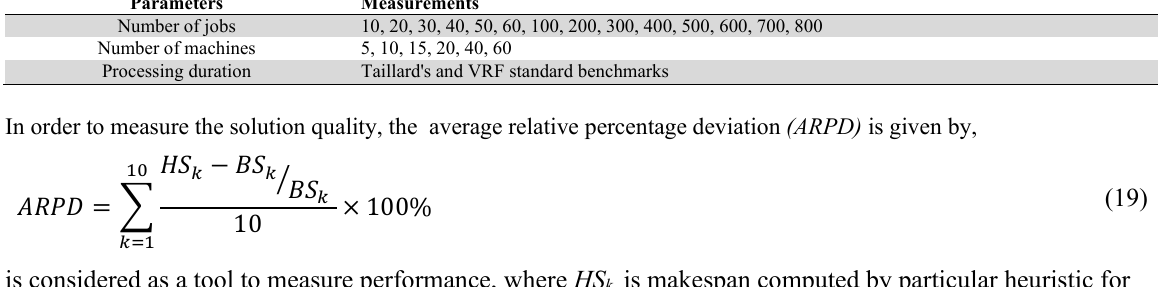
implementing them in an NEH heuristic whenever time